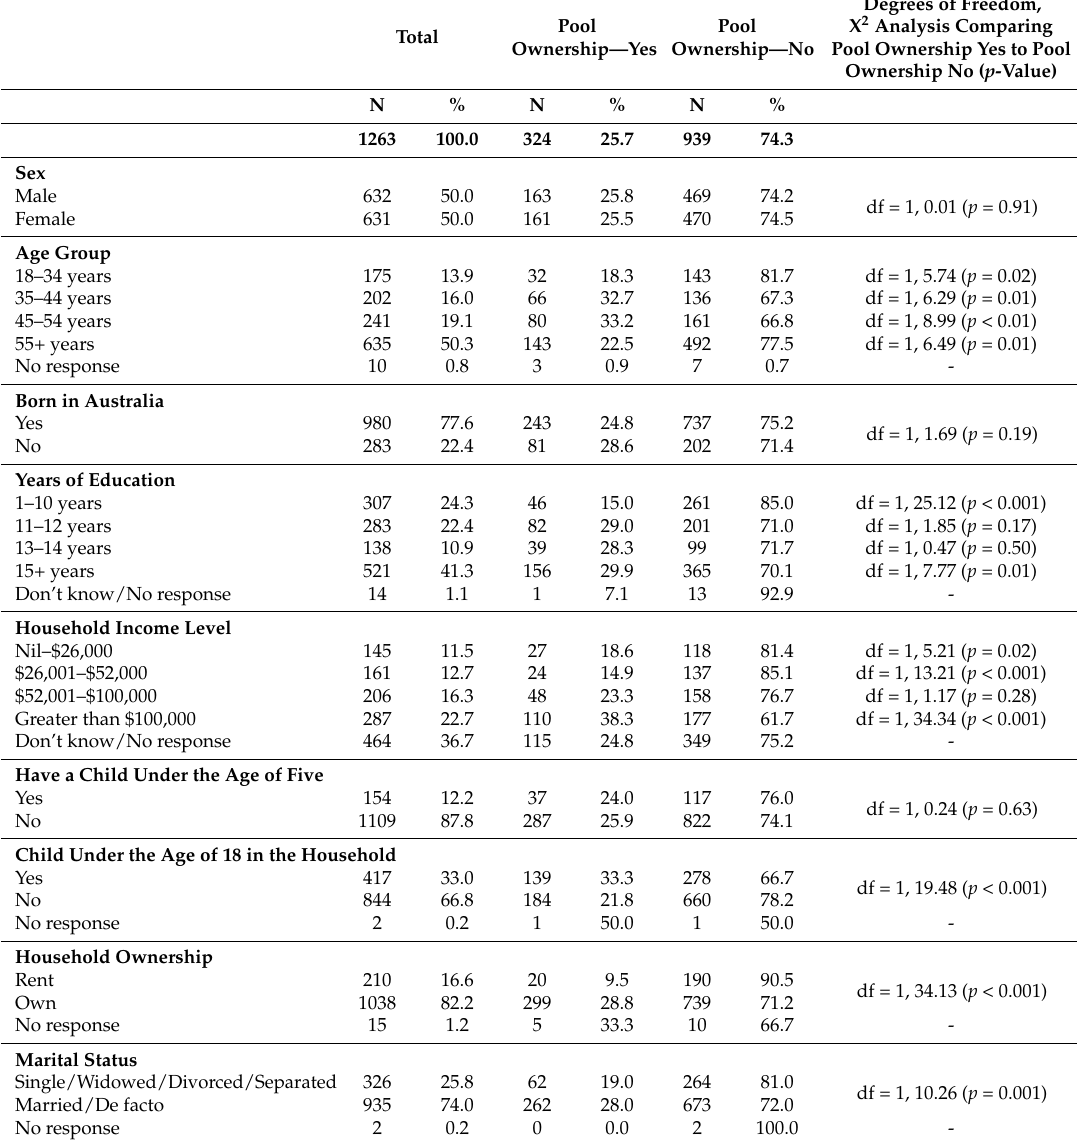
Table 1. Computer Assisted Telephone Instrument (CATI) survey responses by pool ownership yes/no by sex, age group, born in Australia, years of education, household income level, child under the age of five, child under the age of 18 in the household, household ownership, and marital status, Queensland, 2011 ( N =